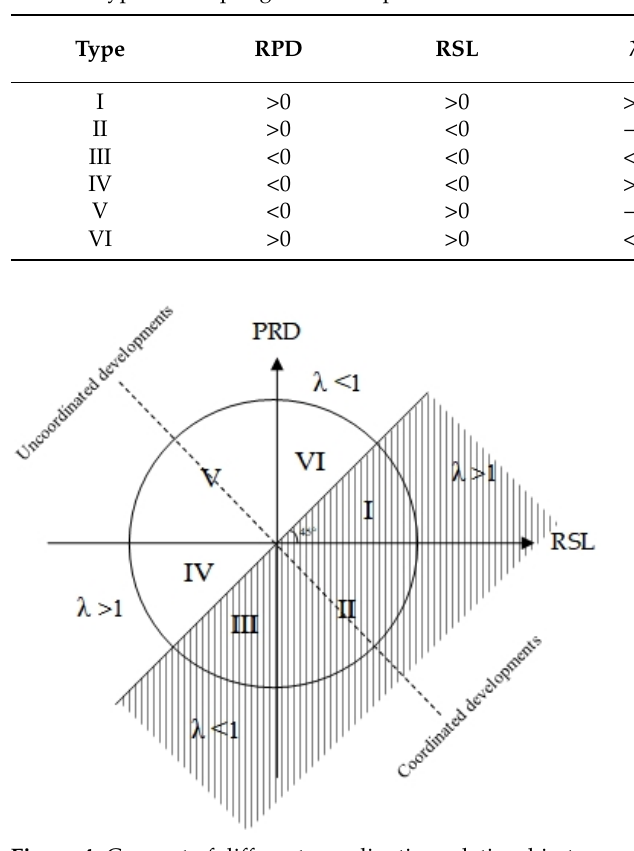
Figure 4. Concept of different coordination relationship types.